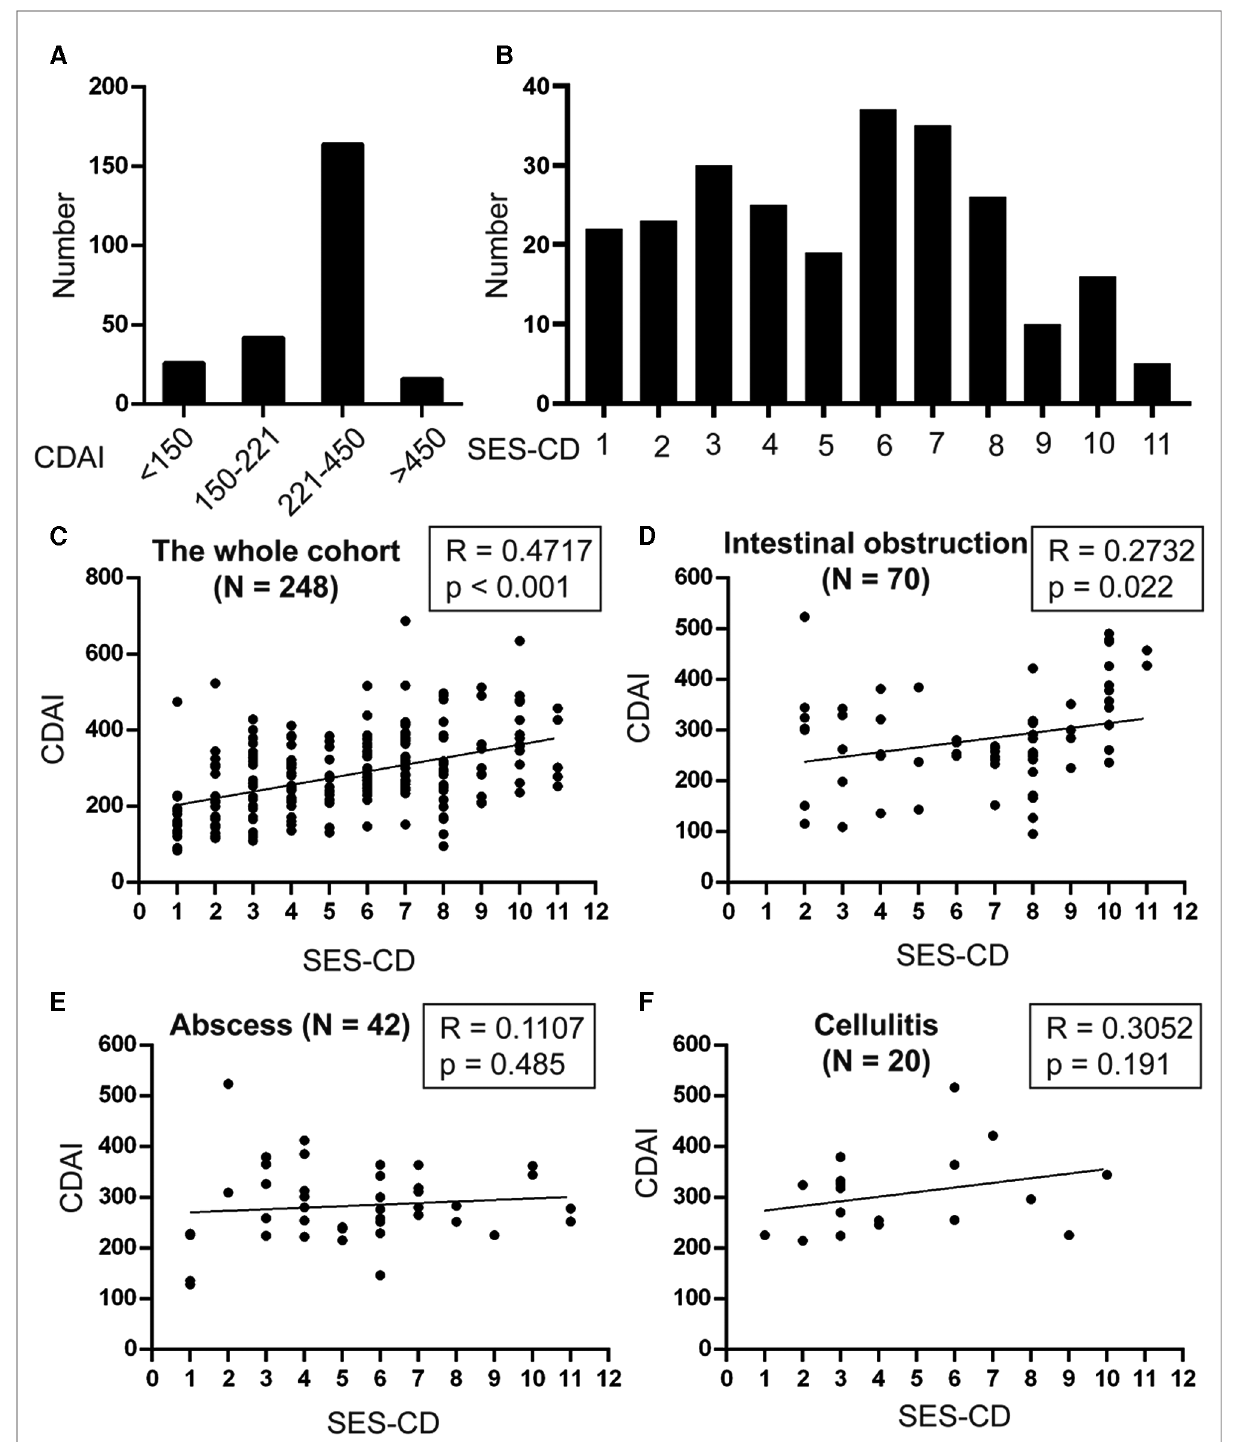
FIGURE 2 Analysis of the distribution and correlation of CDAI and SES-CD. The number of patients with different ( A ) CDAI and ( B ) SES-CD were analyzed. Spearman ’ s correlation test was used to determine the correlation between CDAI and SES-CD in the ( C ) whole cohort, patients with ( D ) intestinal obstruction, ( E ) abscess, and ( F )